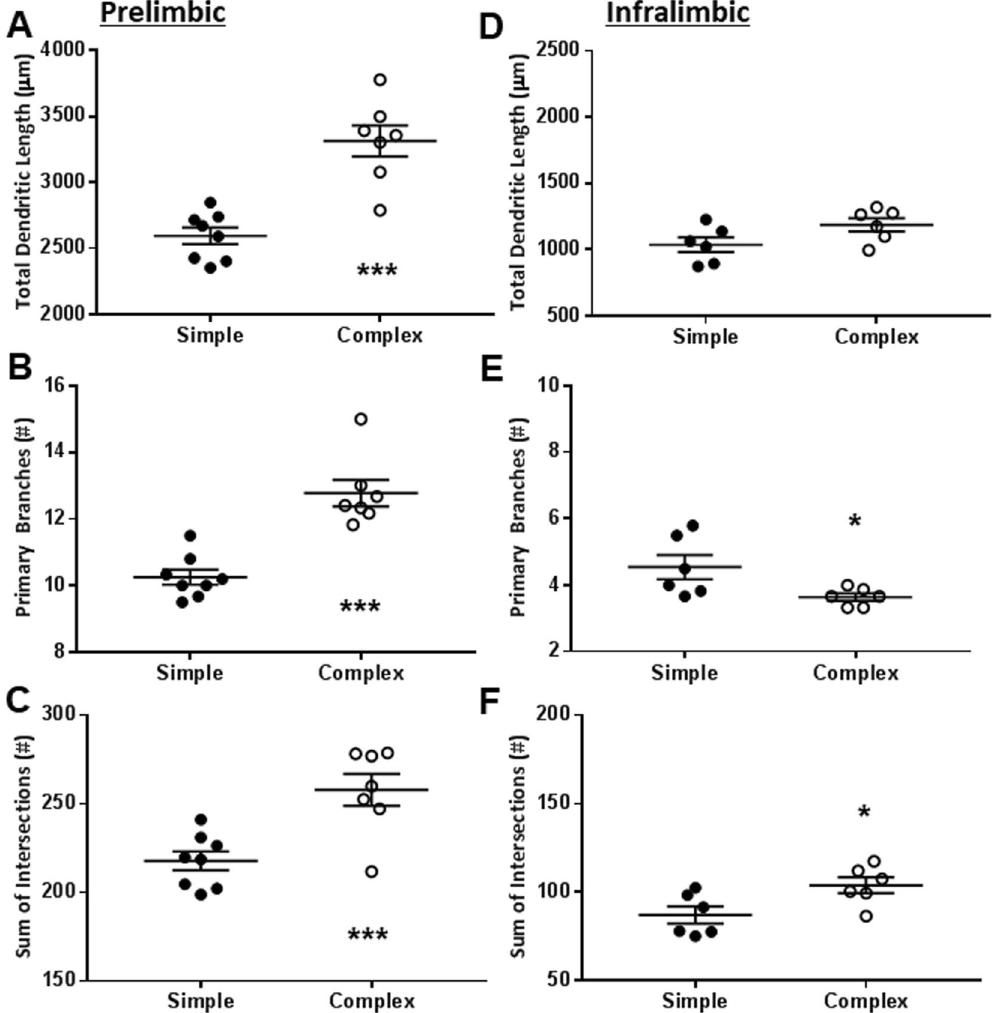
Figure 3. Complex environment increased dendritic complexity of the neurons in prelimbic, but not infralimbic, medial prefrontal cortex. Panels depict mean and SEM, along with individual animals represented as dots. * p < 0.05; and *** p < 0.001; unpaired Student’s t-test. n = 8 animals for simple and 4 for complex environment (prelimbic); and, 6 animals for simple and 6 for complex environment